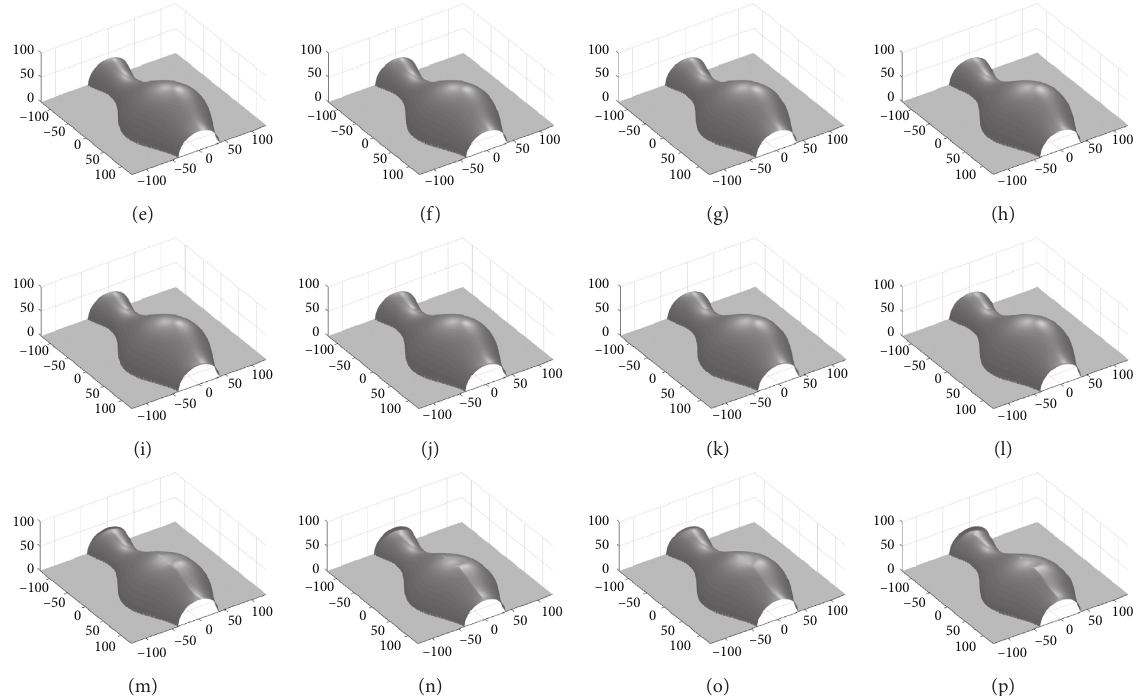
Figure 4: Experimental results for the synthetic vase images. (a)–(d) The shading images generated by the four parameter sets shown in Table 1. (e)–(h) Reconstructed surfaces of (a)–(d) using first-order Godunov-based scheme. (i)–(l) Reconstructed surfaces of (a)–(d) using high-order Godunov-based scheme. (m)–(p) Reconstructed surfaces of (a)–(d) using Lax-Friedrichs sweeping